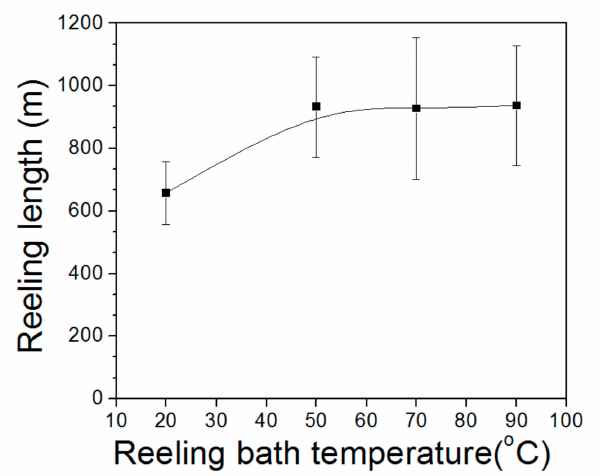
Figure 6. Effect of reeling bath temperature on the reel-ability of silk filament from silk cocoons ( n = 20). The reeling velocity was 39.2